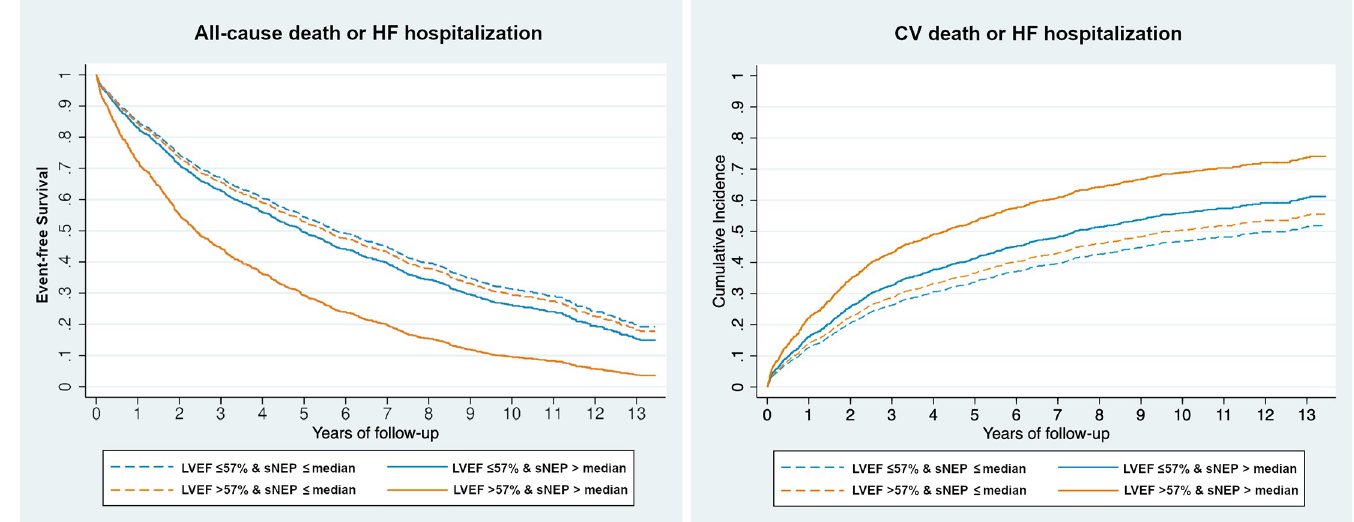
Fig 2. Age- and sex- adjusted event-free survival and incidence curves for every LVEF group, based on sNEP levels above/below the median. Left Panel (A) Primary composite endpoint of all-cause death or HF hospitalization; Right panel (B) Secondary composite end-point of cardiovascular death or HF hospitalization. Dashed lines, patients with sNEP levels below the median; solid lines, patients with sNEP levels above the median. Median values, 0.601 ng/mL in patients with LVEF > 57% (blue lines) and 0.556 ng/mL for patients with LVEF � 57% (orange lines).